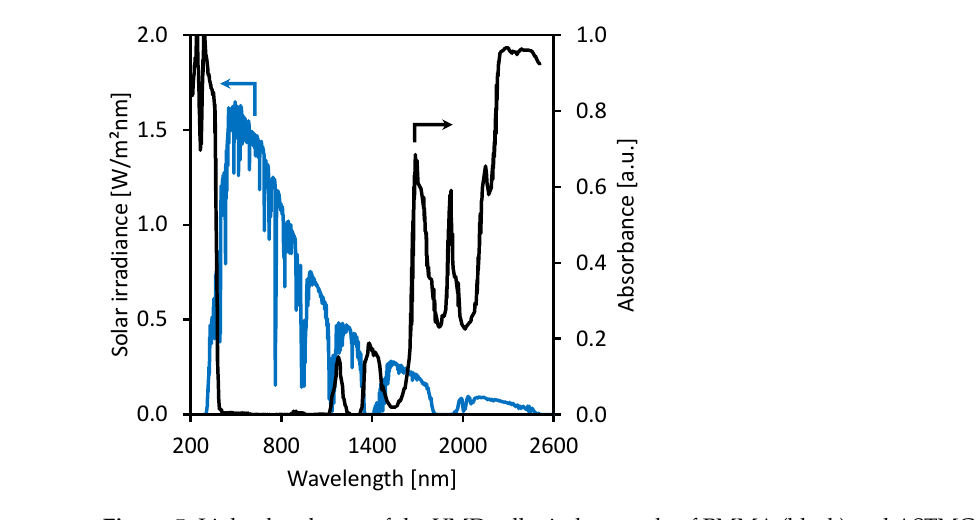
Figure 5. Light absorbance of the VMD cell window made of PMMA (black) and ASTMG 173 AM1.5 solar emission spectrum (blue).